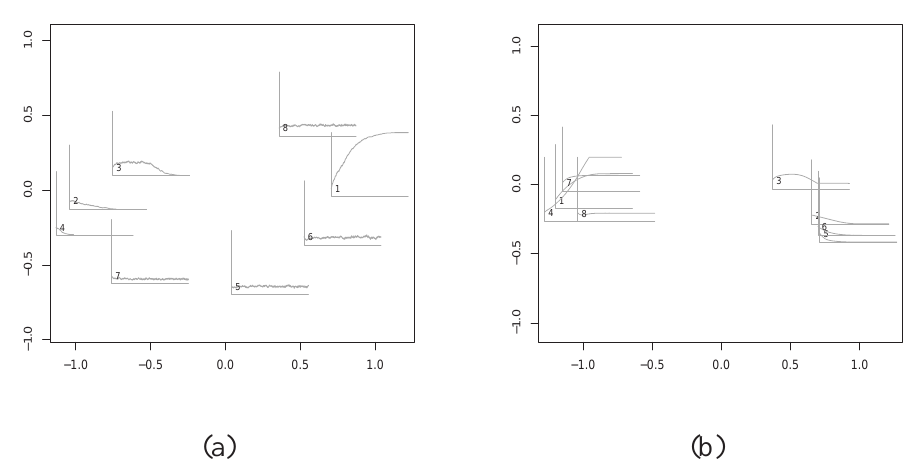
Figure 6: PAMSAM clustering of 45 substrates (excluding c-Fos.DNA, GAP, PP2A, PAK, PP5, PKC) by using (a) Gillespie algorithm and (b) diffusion approximation under the second scenario and t = 20